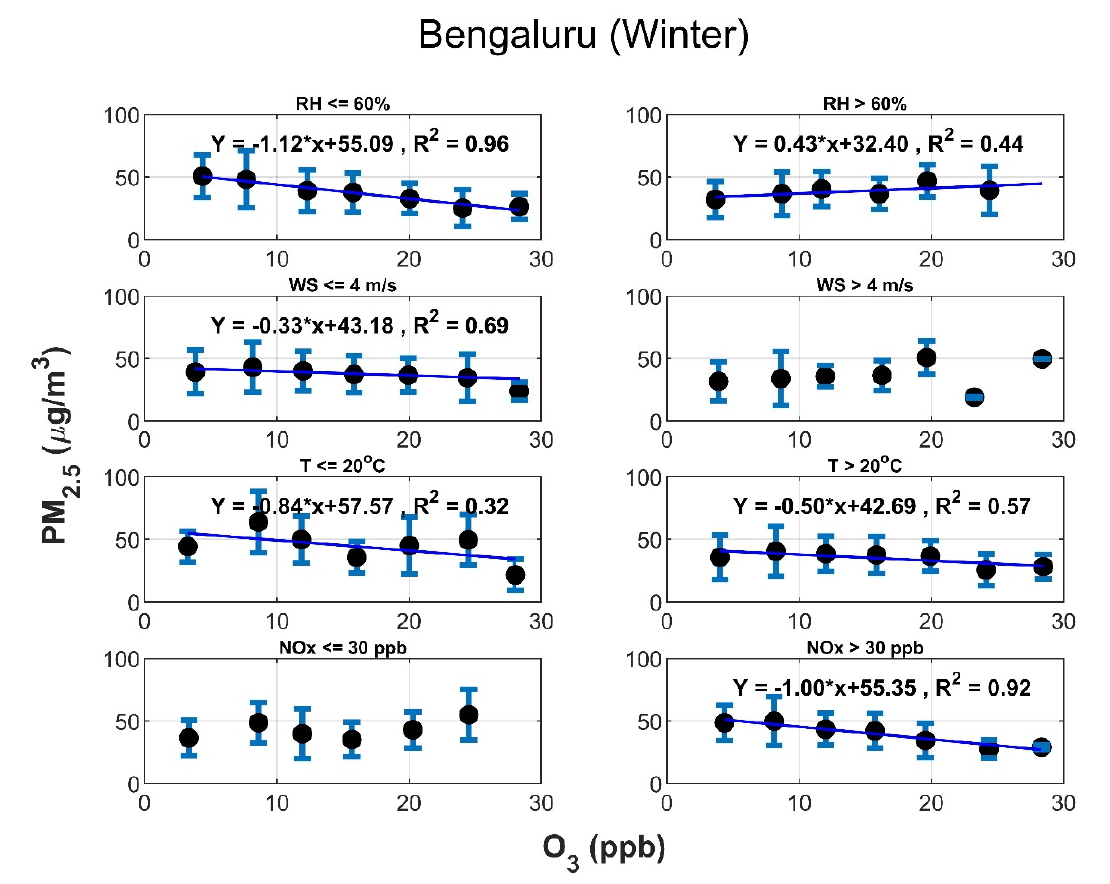
Figure 10. Dependence of PM 2.5 concentrations on O 3 in Bengaluru during the winter season for different meteorological parameters.